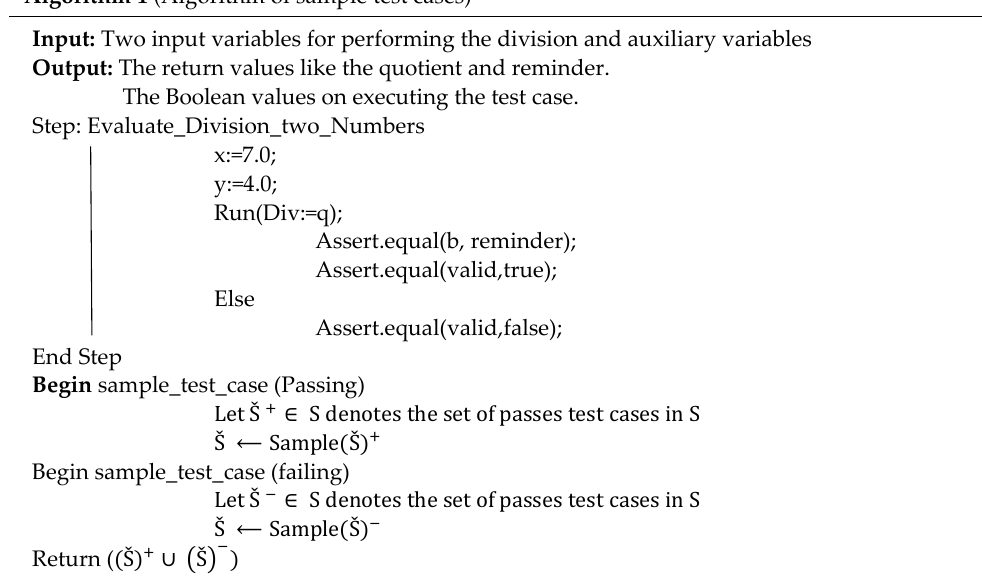
Algorithm 1 (Algorithm of sample test cases)